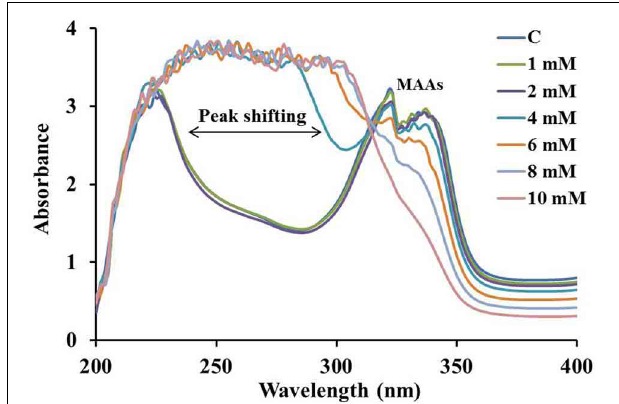
FIGURE 5 | Absorption spectrum of MAAs (0.075mmol.g dry wt − 1 ) in 0–10mM of H 2 O 2 (30%) showing peak shifting toward shorter wavelengths with increasing peroxide concentration.